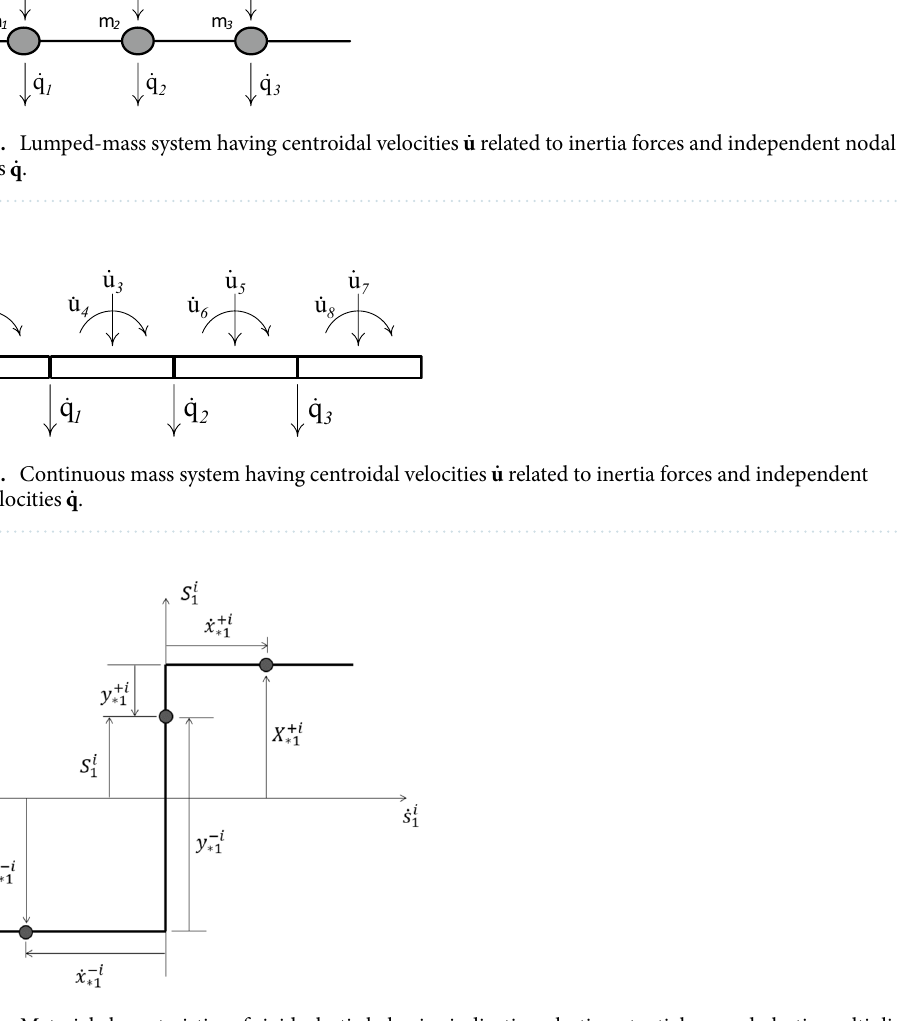
Figure 4. Material characteristics of rigid-plastic behavior indicating plastic potentials y ∗ and plastic multiplier rates ˙ x ∗